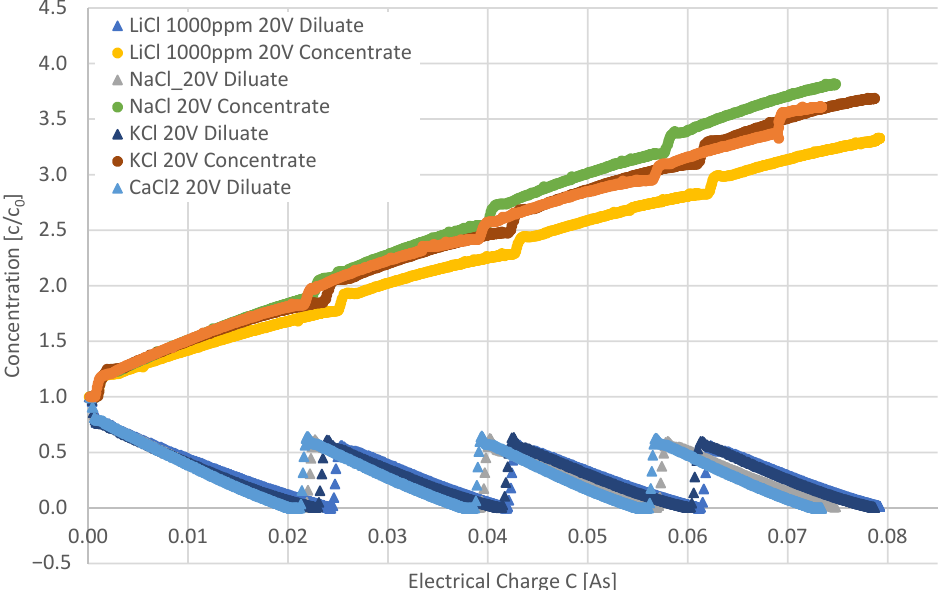
Table 2. Comparison of the current efficiencies (CE), overall and per batch, calculated for the investigations with LiCl, NaCl, KCl, and CaCl 2